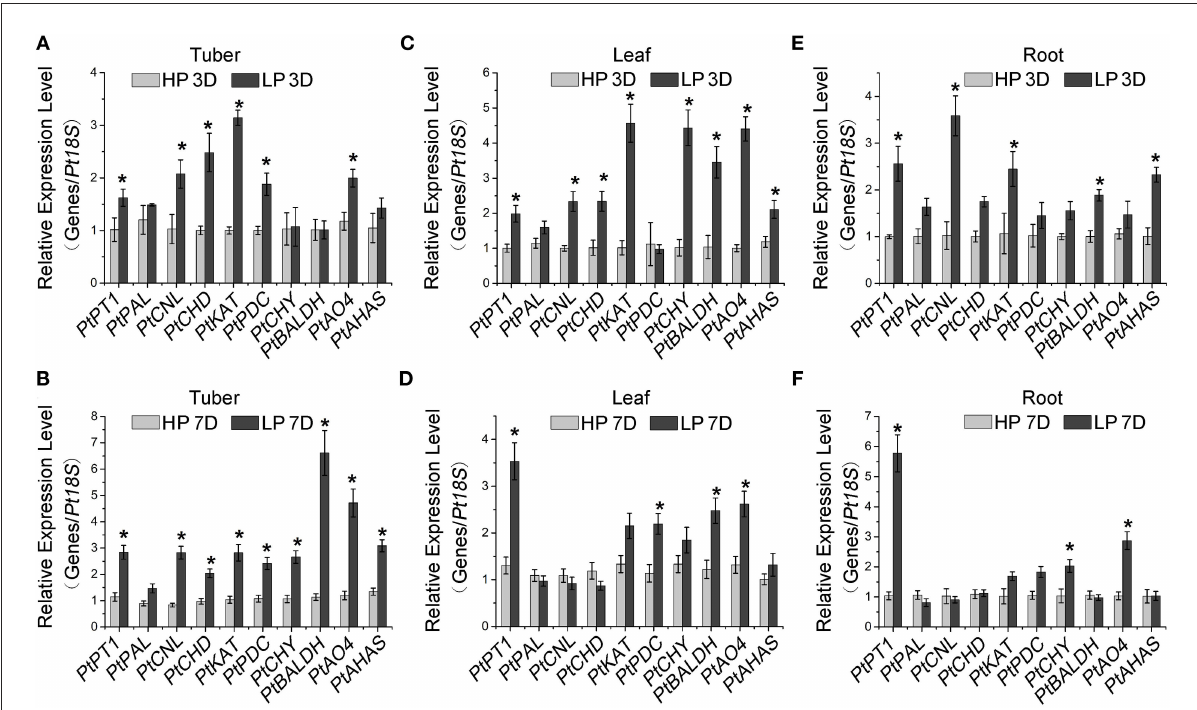
FIGURE2 Induction of alkaloid-responsive gene expression by Pi starvation. RT-qPCR analysis of alkaloid-responsive genes in P. ternata tubers (A,B) , leaves (C,D) , and roots (E,F) upon low Pi treatment for 3 days (A,C,E) and 7 days (B,D,F) . PtPT1 is a marker gene for Pi starvation. Values are means ± SD of three biological replicates. *Indicates a significant difference between high/low Pi treatment at P < 0.05 by Student’s t -test. HP: high Pi, 10mM. LP: low Pi, 10 µ M.